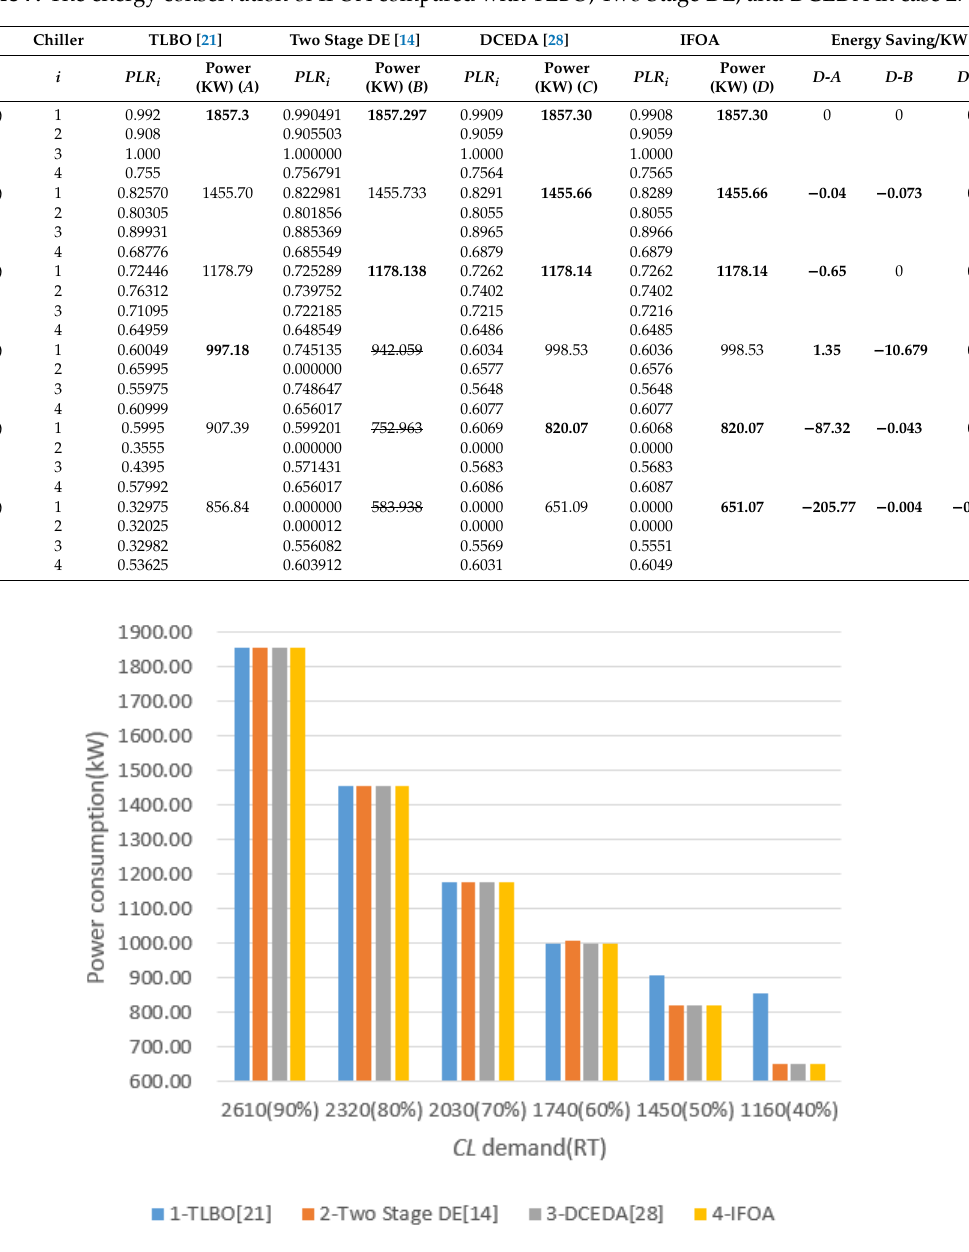
Figure 5. Histogram representation of results in case 2.